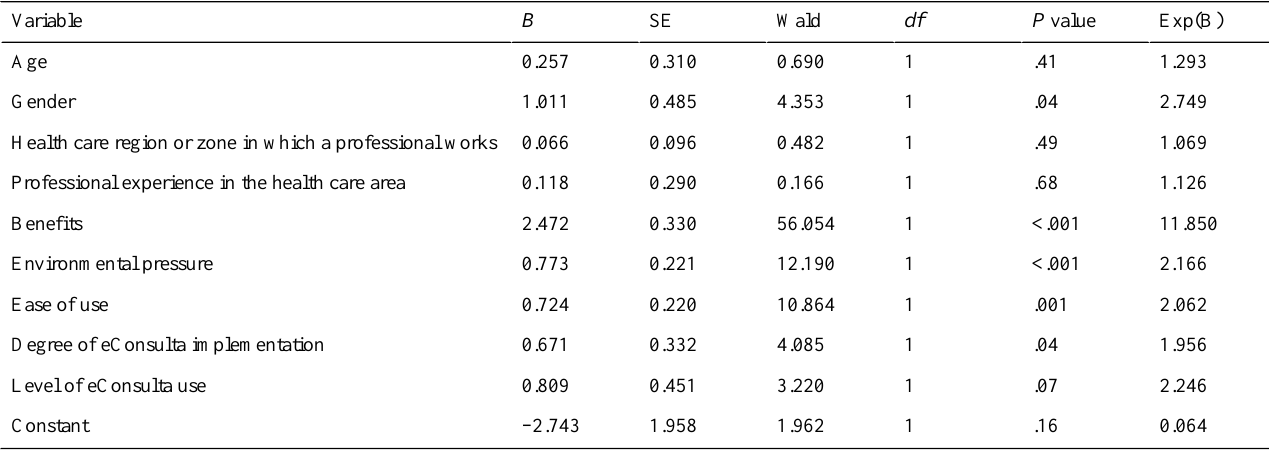
Table 4. Logistic regression on eConsulta predictors (general practitioners).